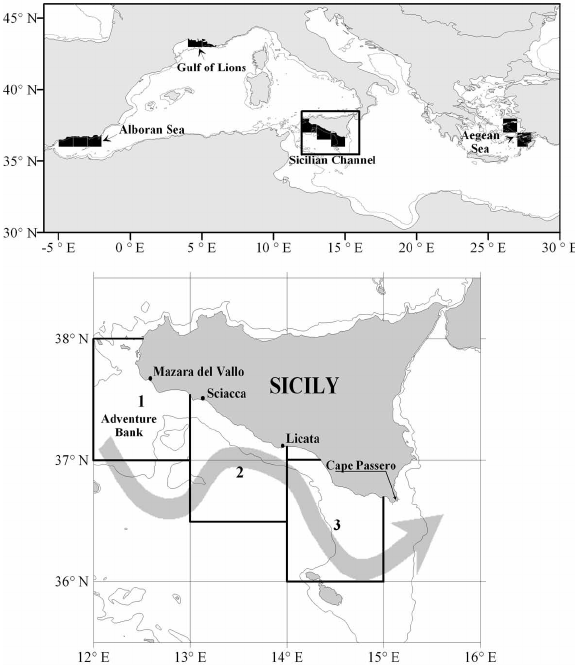
Fig . 1. – Map showing the 1° × 1° of latitude and longitude boxes in the selected Mediterranean upwelling regions (Alboran Sea, Gulf of Lions, Sicilian Channel, and Aegean Sea), where Chl a concen- tration, Ekman transport, wind mixing, nutrient concentration, and water column stability were estimated or extracted from the avail- able databases. The Sicilian Channel area, which time series cross- correlation analysis is based on, is evidenced below. The average path of the Atlantic Ionian Stream (AIS) over the Sicily Channel area and 200 m isobath are superimposed.